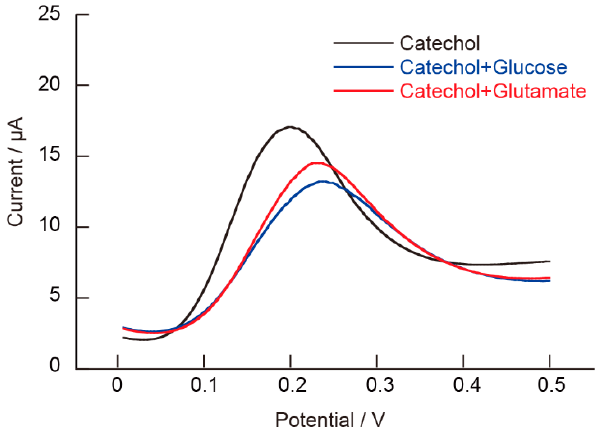
Figure 7. Plots of peak potentials vs. pH in DPV measurements in phosphate buffer solutions (100 mM) containing Glc and Glu using (PAH/AA-PMA) 5 -modified electrode.